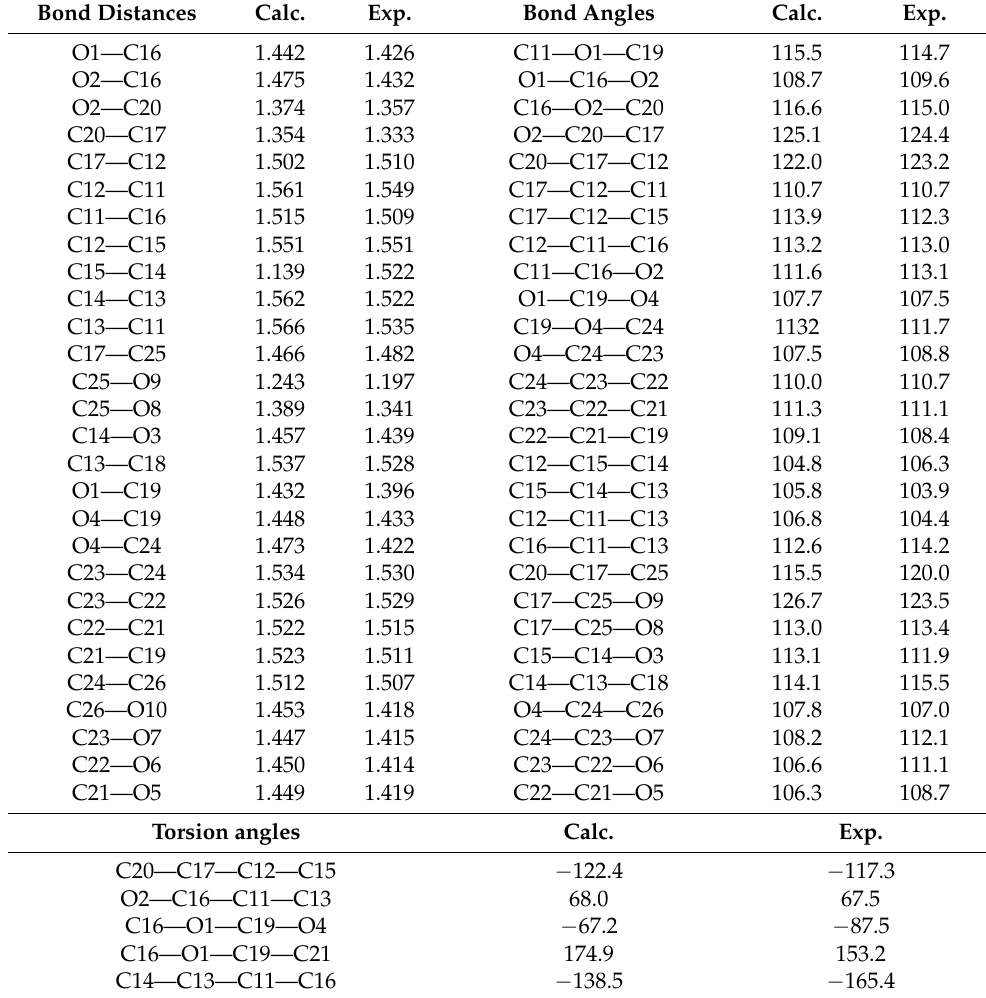
Table 1. Optimized geometrical parameters of loganic acid obtained by DFT calculations compared with the experimental structural data reported for loganin